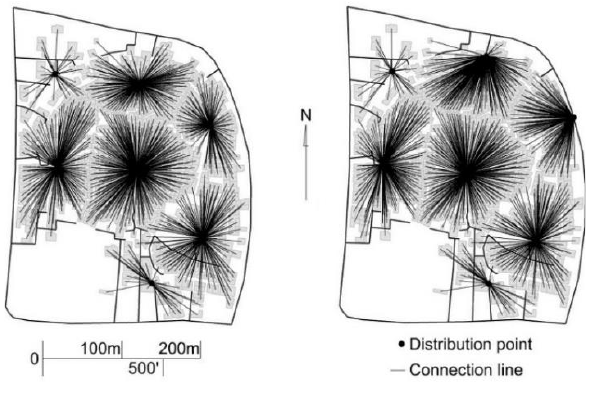
Figure 12. Weighted force adjusted distribution graph (left). Figure 13. Repositioned distribution graph (right).